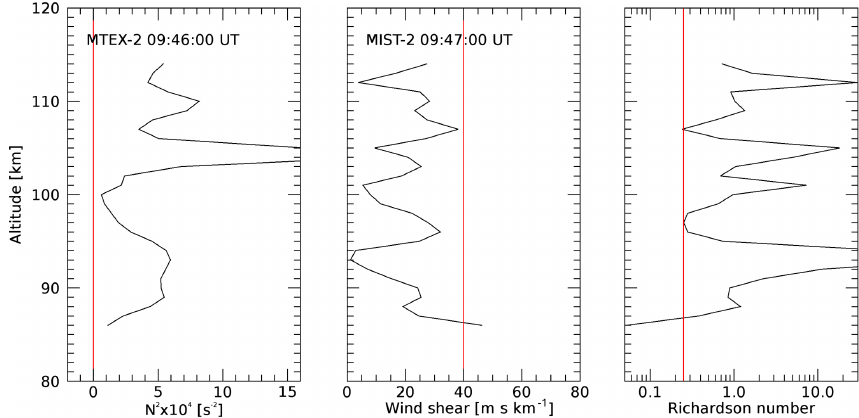
Figure 16. Same as the previous figure but for the second